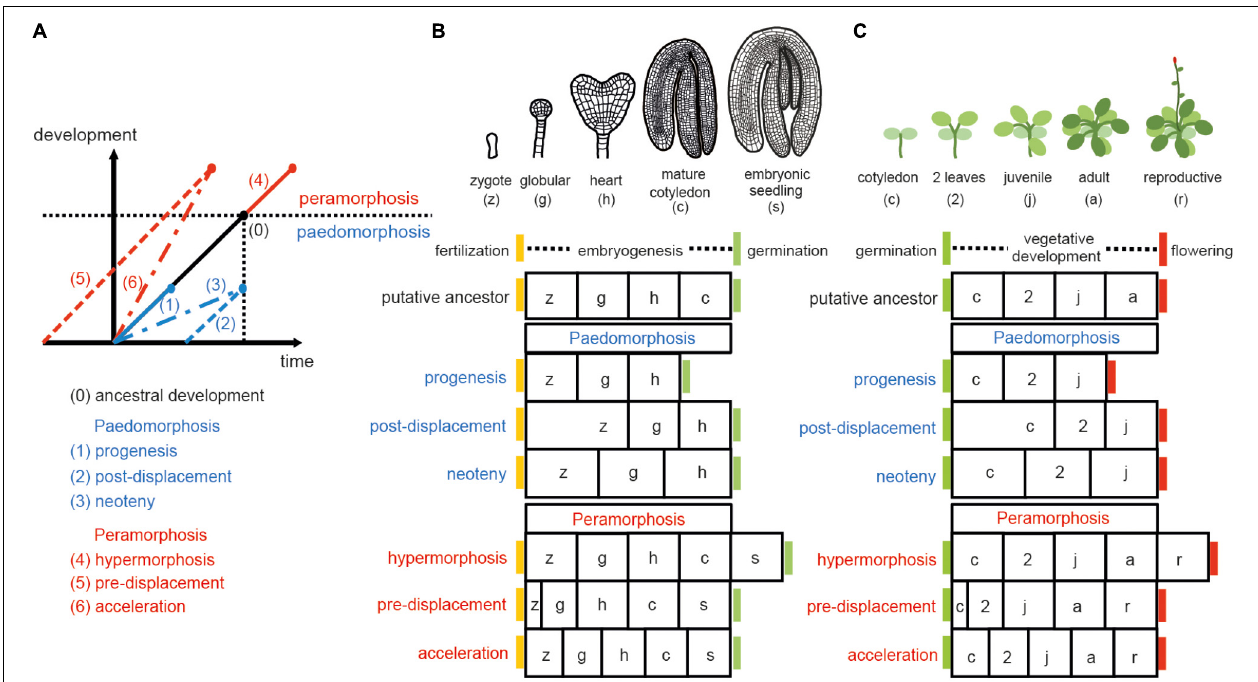
FIGURE 1 | Types of heterochrony. (A) Schematic representation of the 6 types of heterochrony. The black line represents the time required to reach a certain developmental stage in the ancestral ontogeny. Blue lines show the 3 types of paedomorphosis: progenesis (precocious offset), post-displacement (delayed onset) and neoteny (slower developmental rate). Red lines show the 3 types of peramorphosis: hypermorphosis (delayed offset), pre-displacement (precocious onset), and acceleration (higher developmental rate). Drawing in (A) is based on Alberch et al. (1979) and Geuten and Coenen (2013). (B) Heterochrony scenarios for embryogenesis. Arabidopsis embryogenesis is taken here as the hypothetical ancestral development, divided in four stages for illustrative purposes. A fifth stage, where the embryo has produced the first two leaves plus the two cotyledons (denoted embryonic seedling), is proposed as the final stage in peramorphic embryogenesis, whereas paedomorphic embryogenesis is expected to conclude at the heart stage. (C) Heterochrony scenarios for vegetative development. In this case, Arabidopsis vegetative development, where the plant continues producing cauline/reproductive leaves on the stem before flowering (drawn on the top), represents a hypothetical case of peramorphic vegetative development, compared to a hypothetical ancestor which flowers at the adult stage without producing cauline leaves. Paedomorphic vegetative development is predicted to result in plants flowering at the juvenile